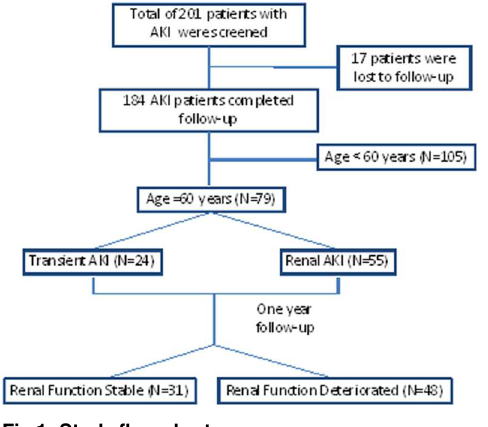
Fig 1. Study flow